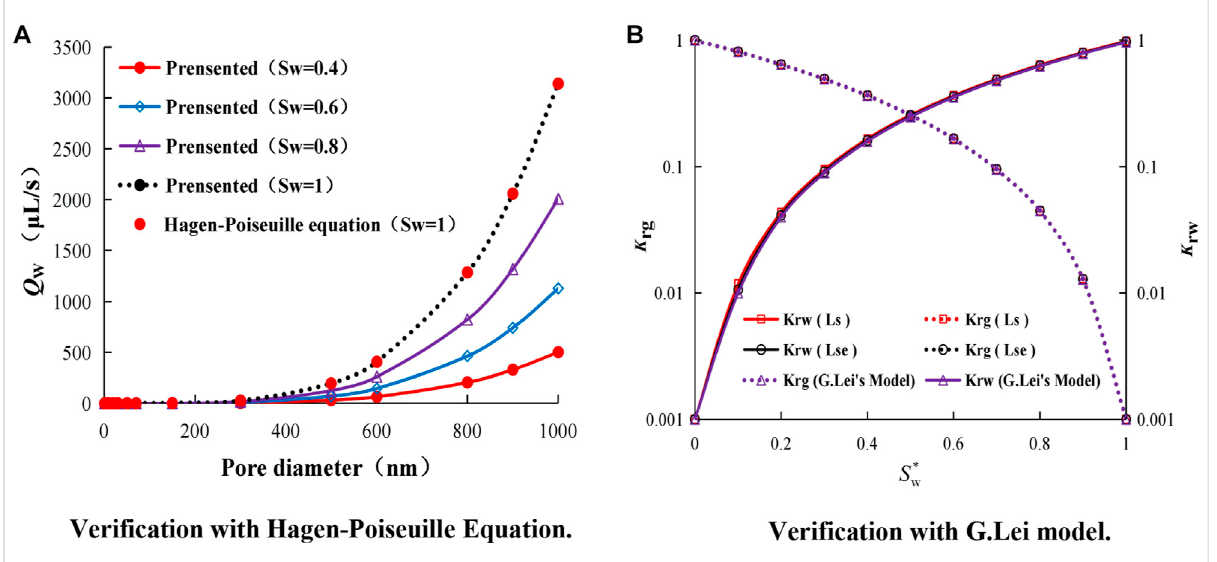
Single capillary nanopore relative permeability